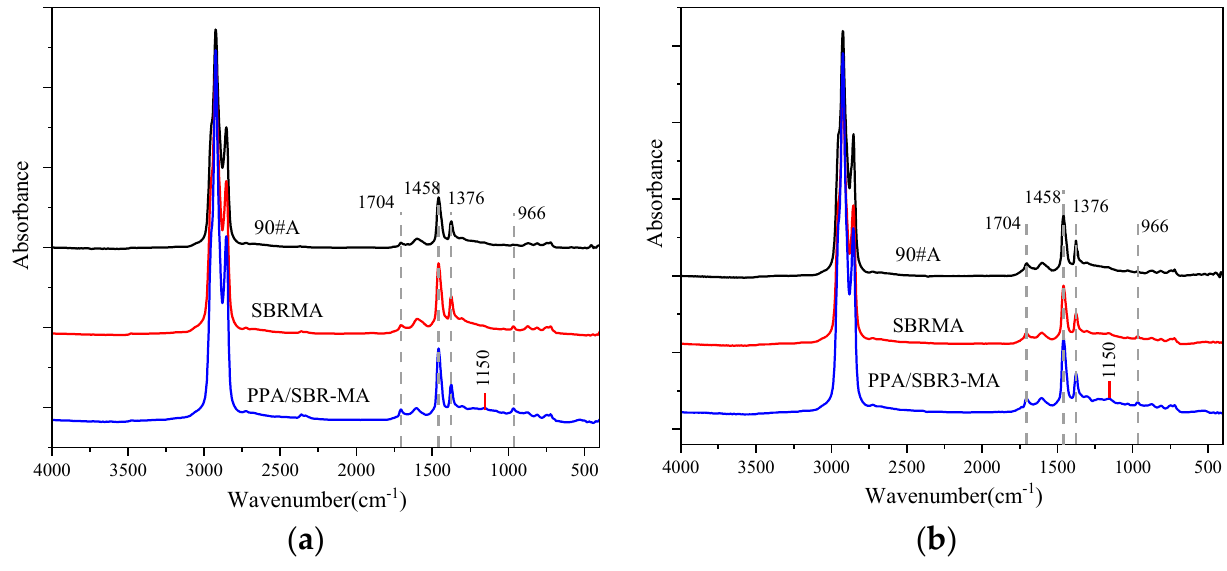
Figure 9. FTIR spectra of asphalt. ( a ) virgin; ( b ) UV aged.